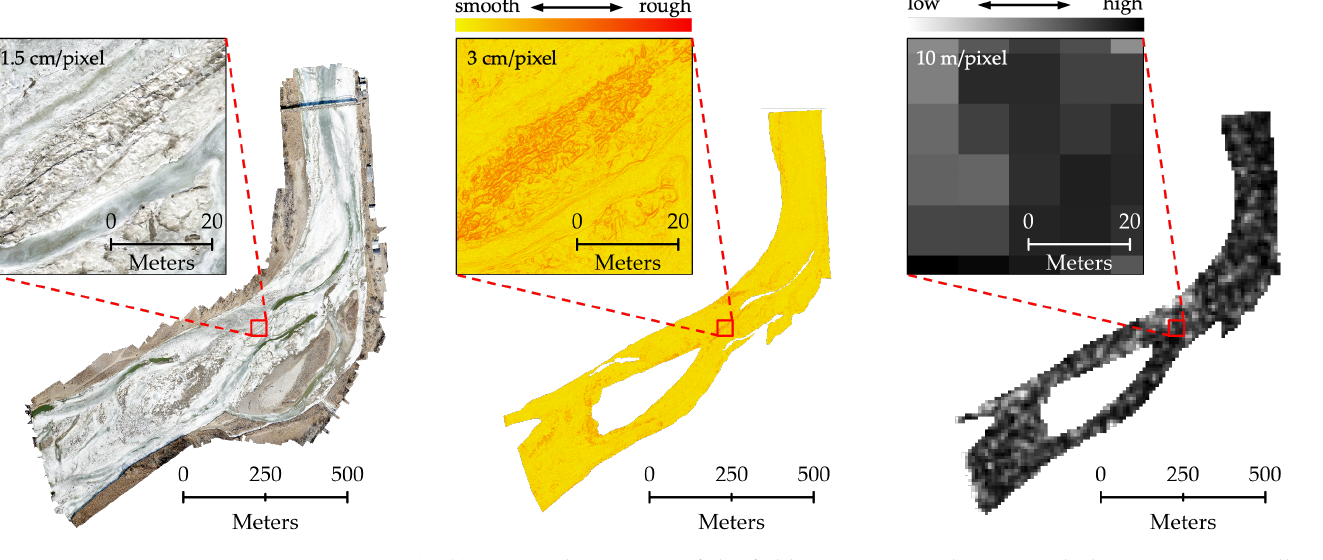
Figure 3. ( Left ) UAV orthoimagery of the field site on 4 March 2021, including river ice, small open water leads, islands, and riverbanks. ( Middle ) Surface roughness measurements derived from 4 March UAV DEM, clipped to the ice surface. ( Right ) Sentinel-1 VH backscatter from 2 March clipped to the ice